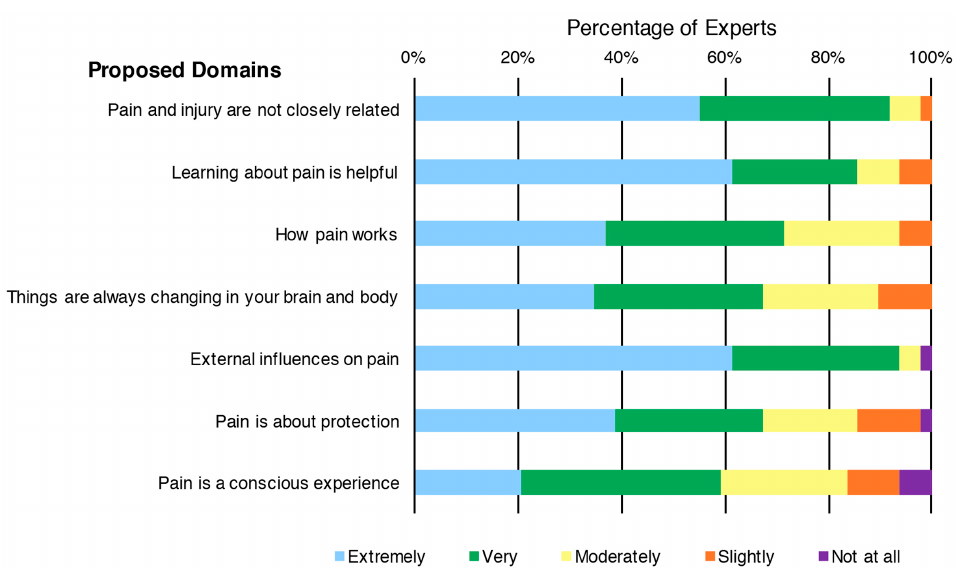
Figure 3. Distribution of pediatric pain experts’ ratings of the usefulness of the content of each item from the Explain Pain Target Concepts, and the need for rewording, in assessing a child’s concept of pain in children aged 8–12 years.